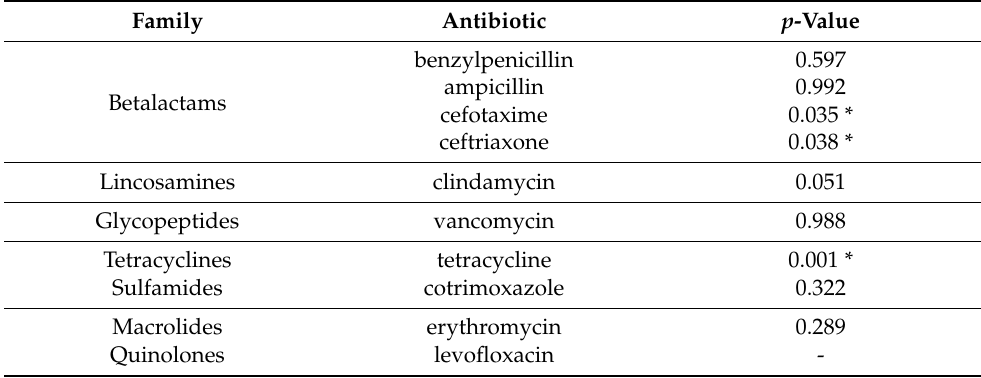
Table 1. Co-selection of Hg MBC and AR in the isolated Bacillus spp. strains. Family Antibiotic p -Value